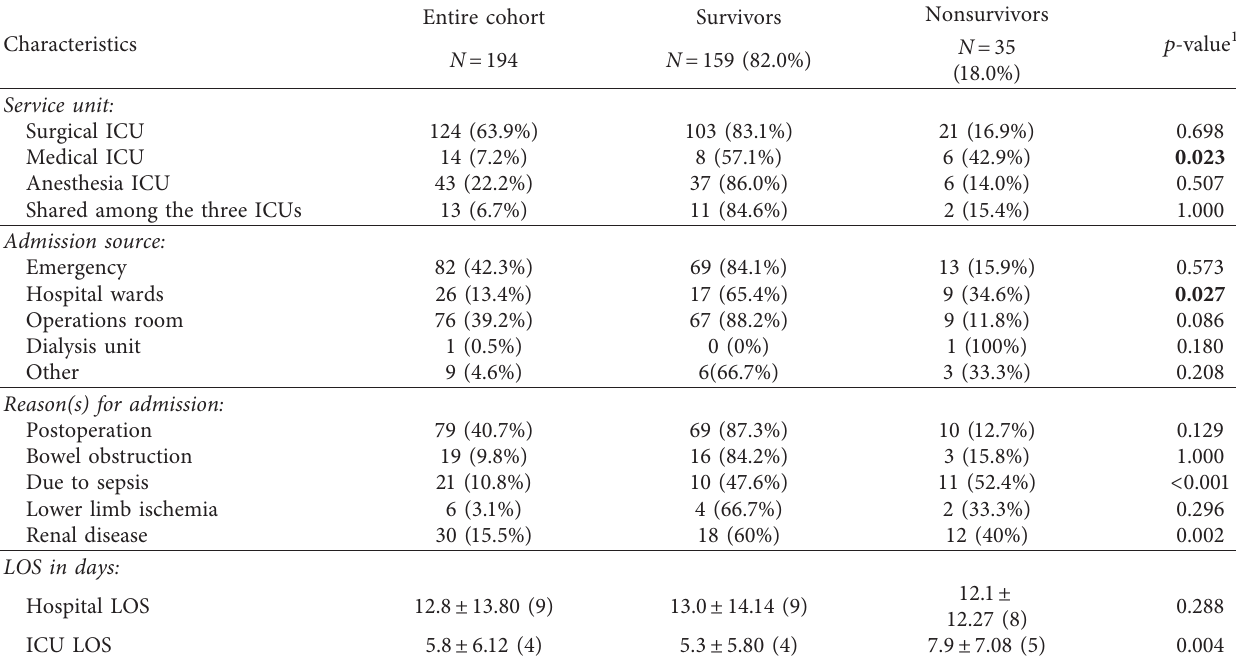
Table 2: Characteristics related to ICU admission and stay in the study cohort divided by outcome.